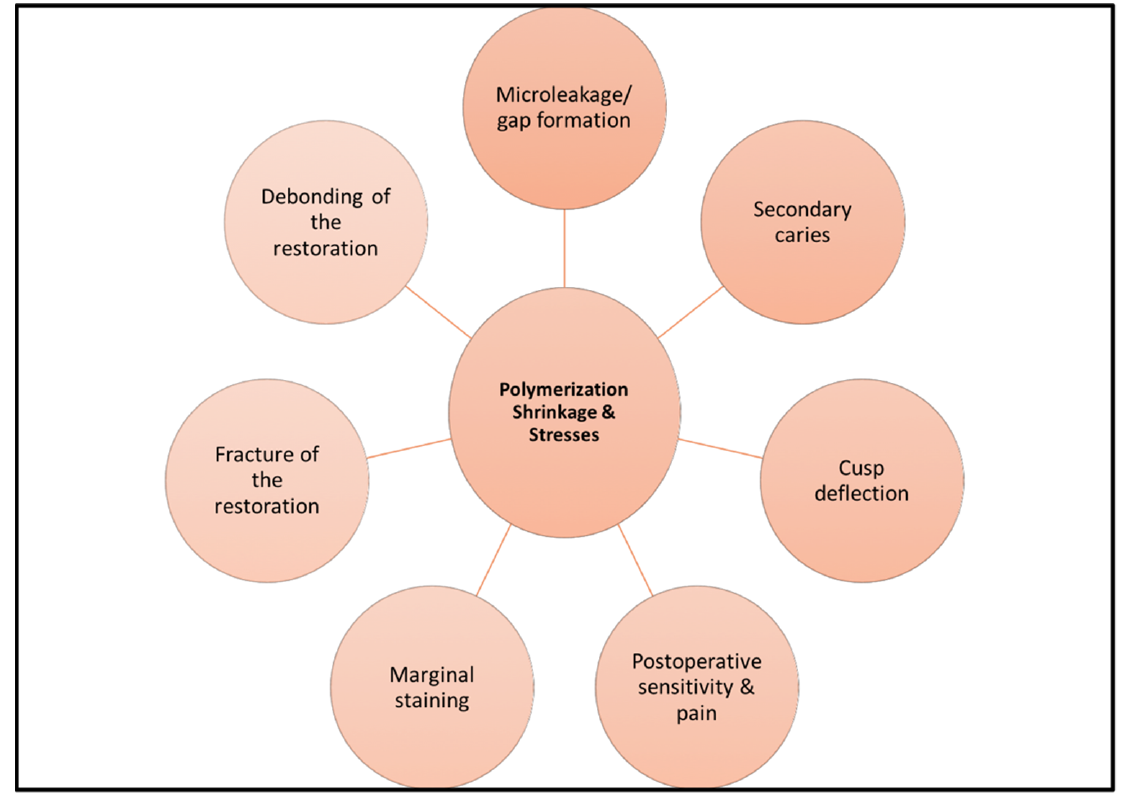
Figure 2. The illustration shows the side effects of polymerization shrinkage and shrinkage-related stresses.